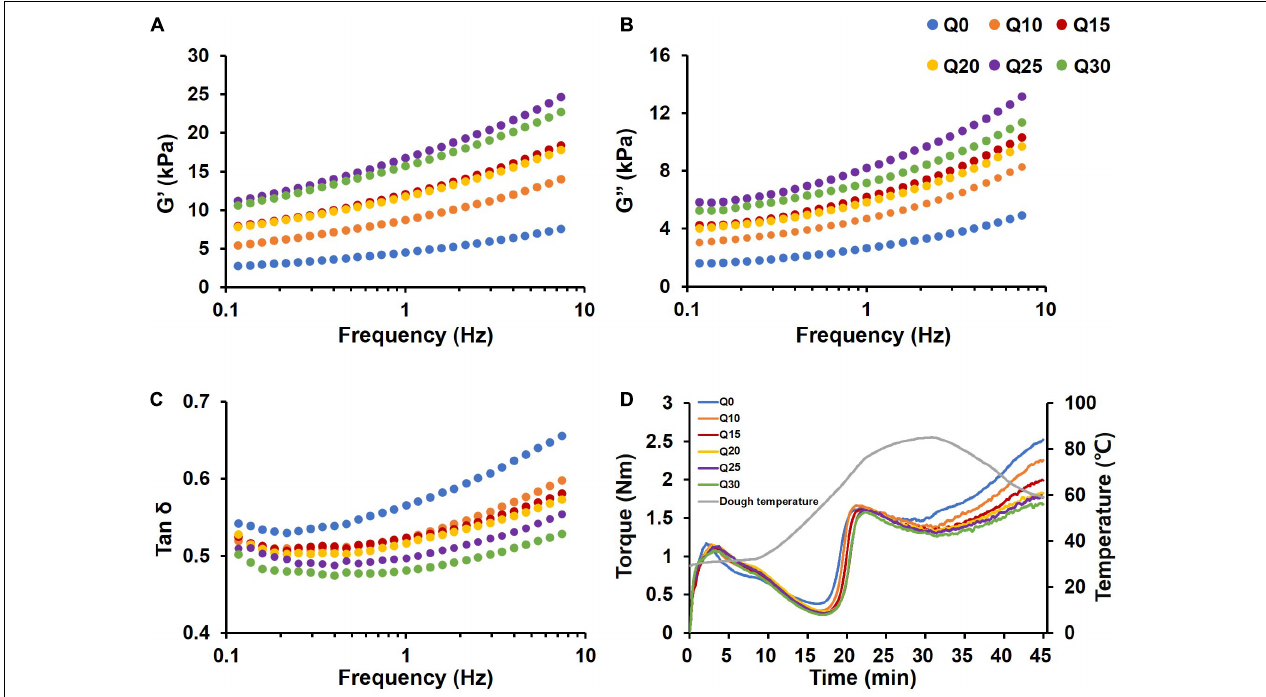
FIGURE 1 | Rheological properties of wheat and quinoa reconstituted doughs. (A) Storage modulus (G (cid:48) ). (B) Loss modulus (G (cid:48)(cid:48) ). (C) Tan δ . (D) The mixing profiles of doughs. The data were obtained from two replicates of each sample.